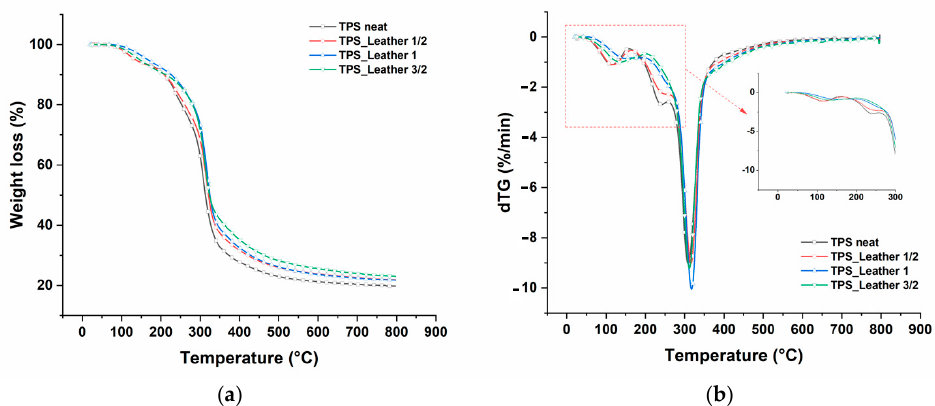
Figure 6. Thermogravimetric curve (TGA) ( a ) and first derivative of the thermogravimetric curve (DTG) ( b ) of thermoplastic starch (TPS) and the different composite